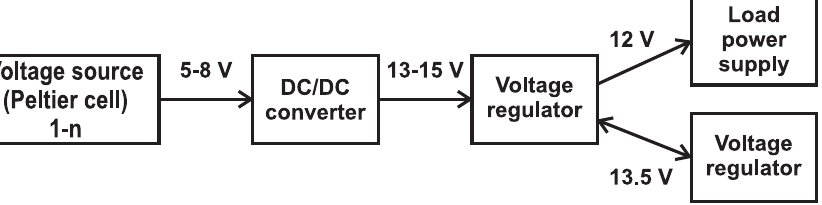
Figure 2. Block scheme.